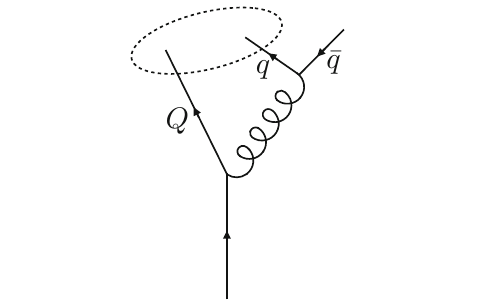
Fig. 1 The configuration that renders jet flavour definition infrared unsafe at NNLO is depicted: a quark Q emits an intermediate soft gluon that subsequently splits into a quark–anti-quark q ¯ q pair. Only one of the gluon’s decay products, say q , is clustered with the original quark Q and so the jet flavour is determined by soft physics. Note that the dotted oval can either represent the boundary of the original jet or the effective boundary induced by